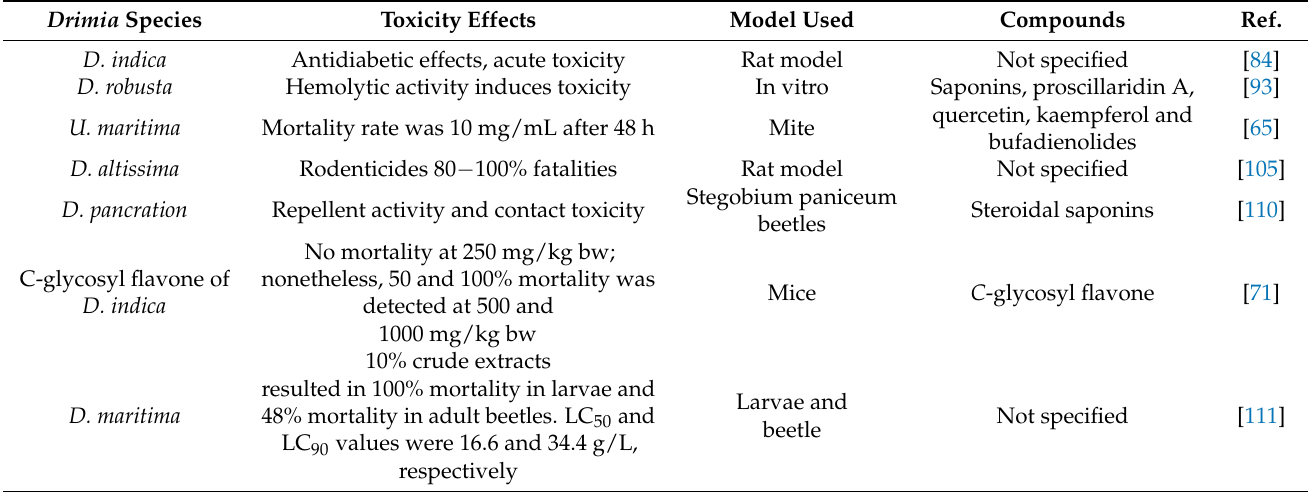
Table 2. Toxicological effects of Drimia species.